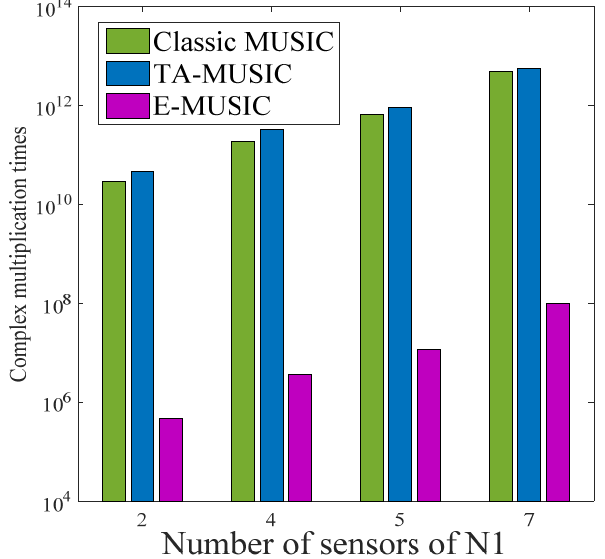
Figure 2. Algorithm complexity according to number of sensors.